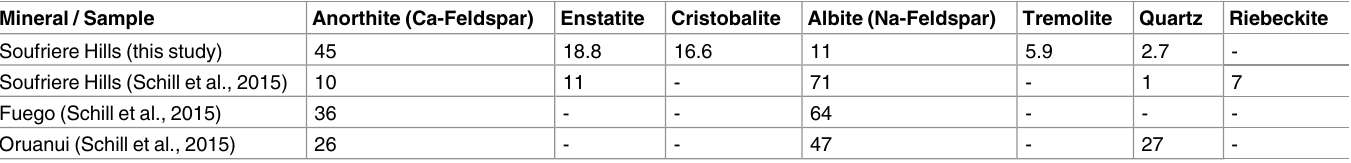
Table 1. Mineralogy of the ash sample (%) used here and the samples used by Schill et al. [23]. Mineral / Sample Anorthite (Ca-Feldspar) Enstatite Cristobalite Albite (Na-Feldspar) Tremolite Quartz Riebeckite Soufriere Hills (this study) 45 Soufriere Hills (Schill et al.,